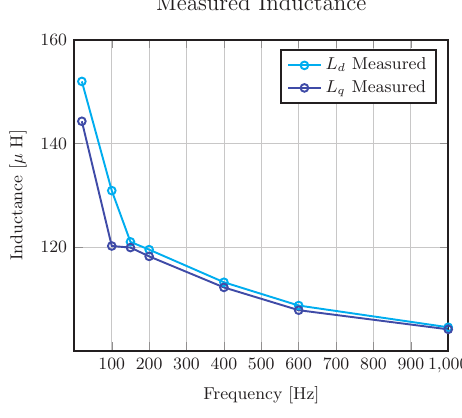
Figure 24. Variation of inductance with frequency. Table 2. Summary of inductance and resistance measured and